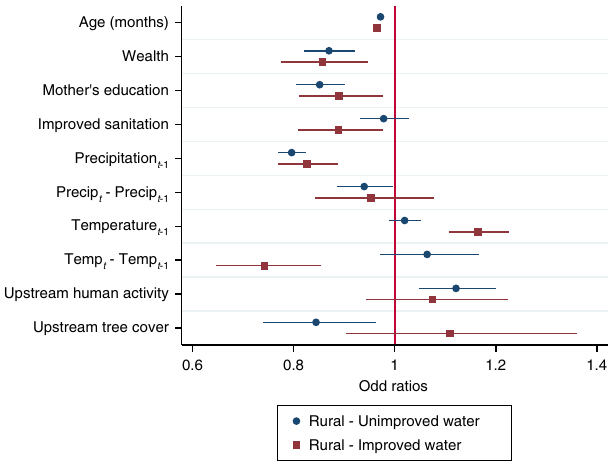
Fig. 4 Factors associated with childhood diarrheal disease differ between rural households with improved and unimproved water. Variables reducing the probability of diarrheal disease (DD) have odds ratios lower than 1 to the left of the red vertical line. Odds ratios and 95% con fi dence intervals (horizontal lines) show statistically signi fi cant associations (con fi dence intervals do not cross the red vertical line) between socioeconomic variables and the probability of DD in both groups. However, the associations between watershed variables (human activity and tree cover) and the probability of DD are signi fi cant for rural households with unimproved water, but not for rural households with improved water. See Supplementary Table 1 for model coef fi cients